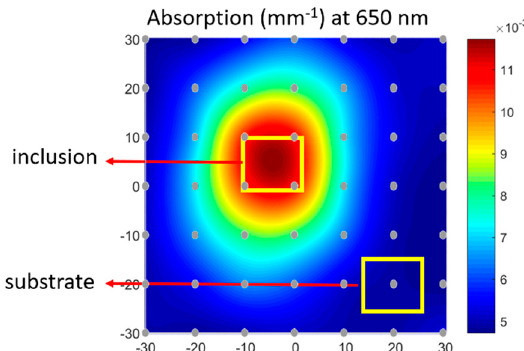
Figure 7. Spatially interpolated topographic DOI recovered absorption at 650 nm with region of interest (ROI) selection for tumor and normal regions.